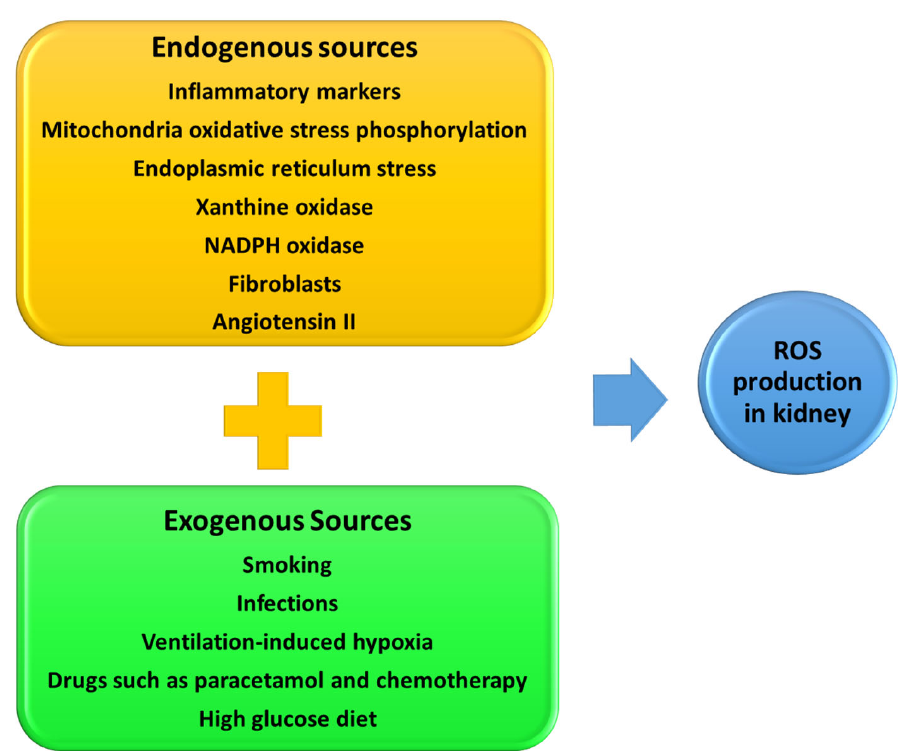
Figure 8. Major sources of reactive oxygen species (ROS) in the kidney.